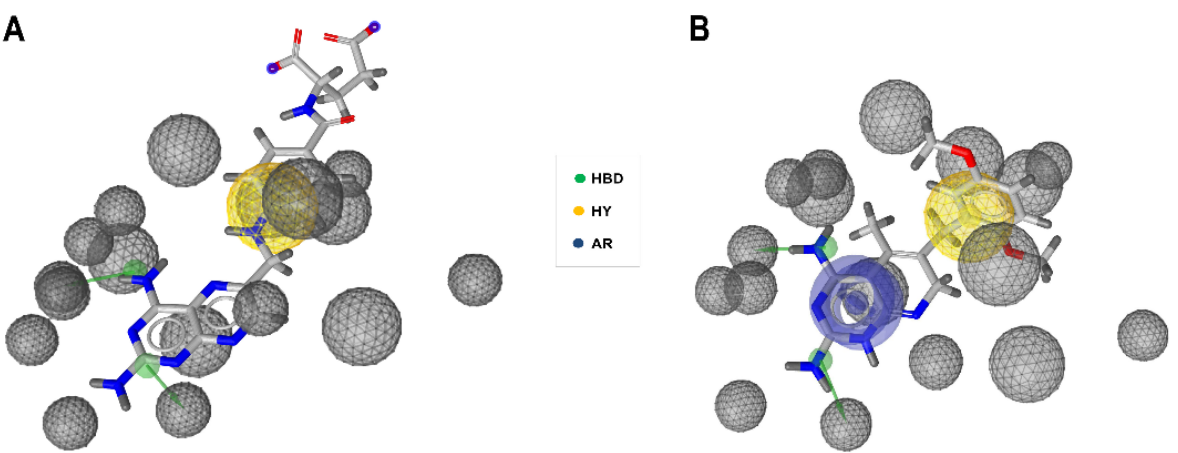
Figure 2. Pharmacophore models generated by the software LigandScout. Overlay of pharmacophore models ( A ) Pharm-A and ( B ) Pharm-B with the well-known active compounds aminopterin (AMT) and piritrexim (PTX), respectively. Both of these compounds were used in the decoy set. Pharmacophore features are colored as follows: hydrogen bond donor—HBD (green), hydrophobic group—HY (gold), and aromatic ring—AR (blue). Gray spheres represent excluded volume. The two H-bond donor groups point to hDHFR active site residues Ile7 and Glu30 respectively.